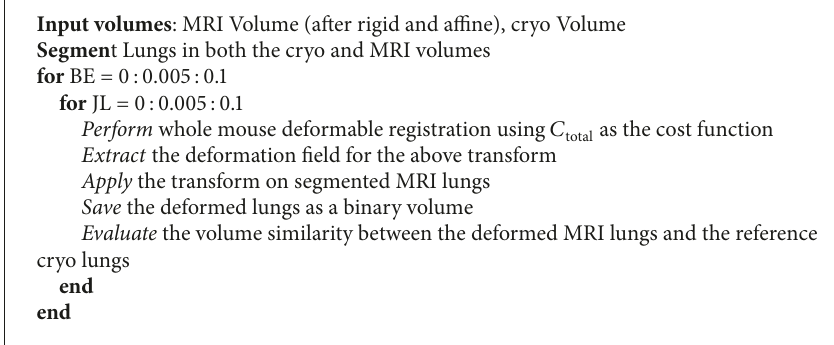
Algorithm 1: Pseudocode to find optimal parameters for cost function using